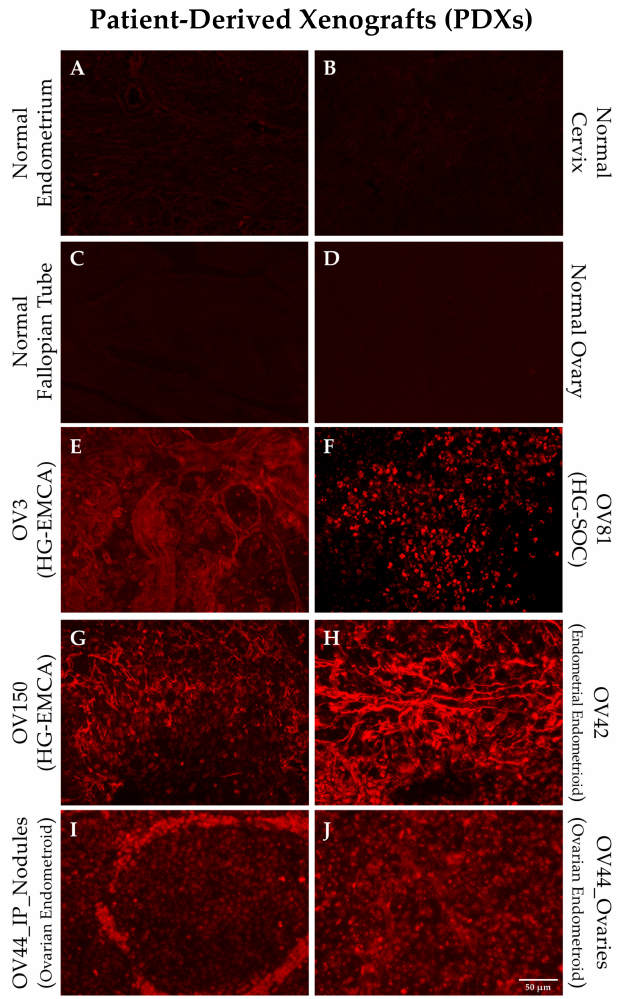
Figure 1. Staining of individual patient derived xenograft (PDX) tissue with SBK4-TR illustrate the high level of SBK4-TR staining intensity for different gynecological cancer PDXs ( E – J ) compared to normal controls ( A – D ). All of the samples had a higher level of staining than normal uterine, fallopian, ovarian, or cervical tissue. Panel I shows a metastasis from the primary tumor in panel J . Scale bar = 50 µ